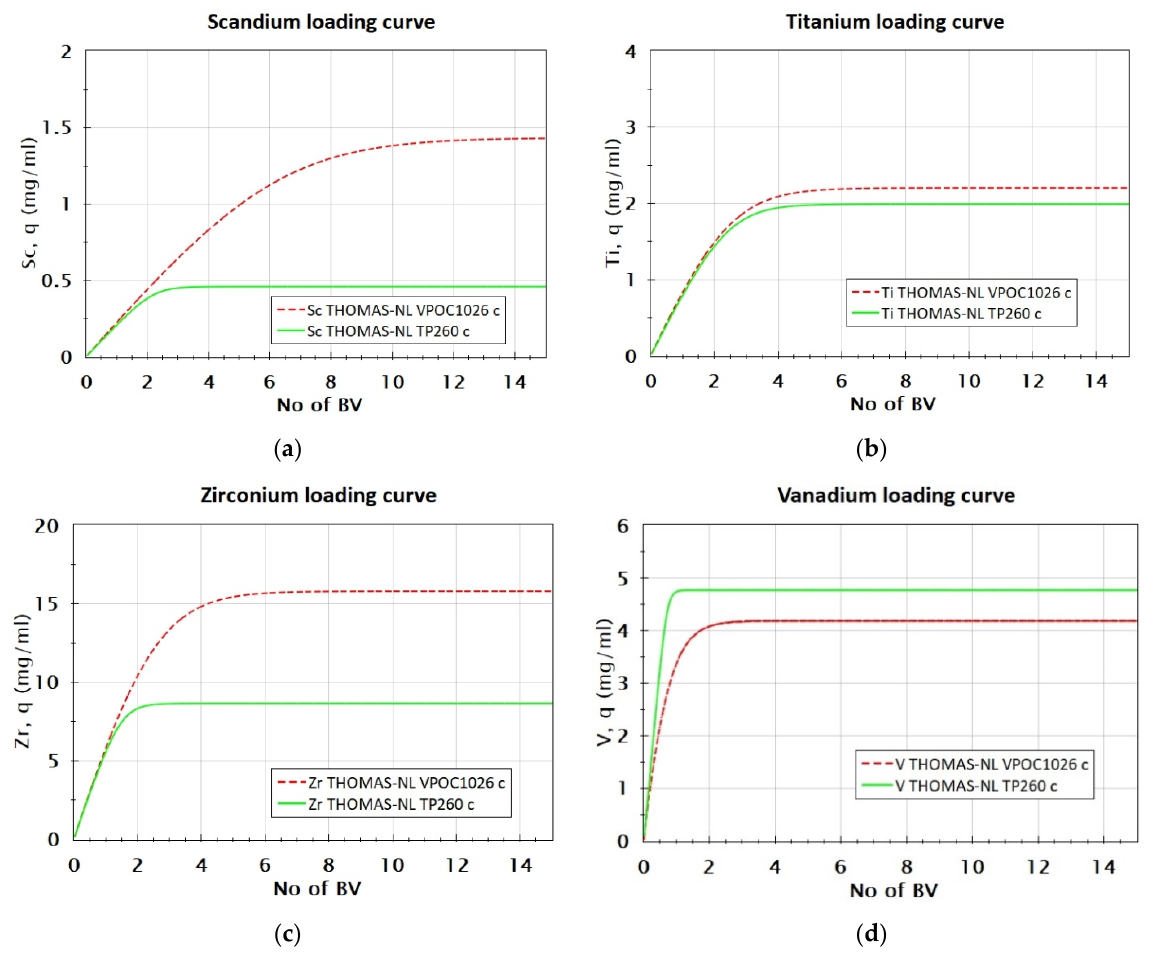
Figure 7. Breakthrough curve of ( a ) Sc, ( b ) Ti, ( c ) Zr, and ( d ) V for VP OC 1026 and TP 260 resin according to Thomas nonlinear (NL) prediction mathematical model.